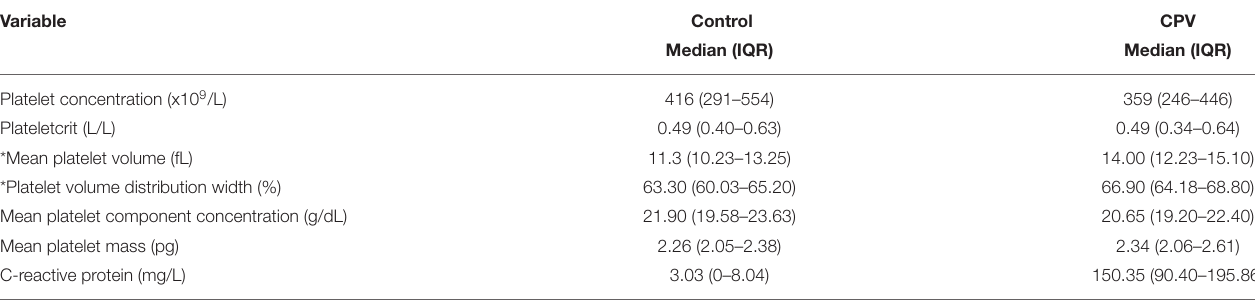
TABLE 1 | Platelet indices and CRP concentration at presentation for dogs with CPV enteritis and healthy controls.